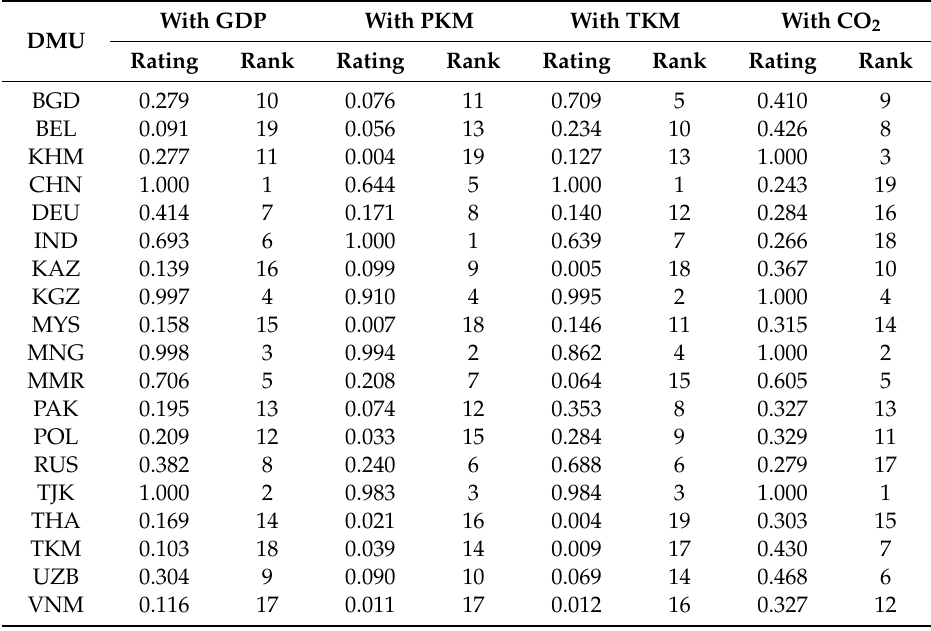
Table 6. E ffi ciency rating and ranks with individual outputs for the year